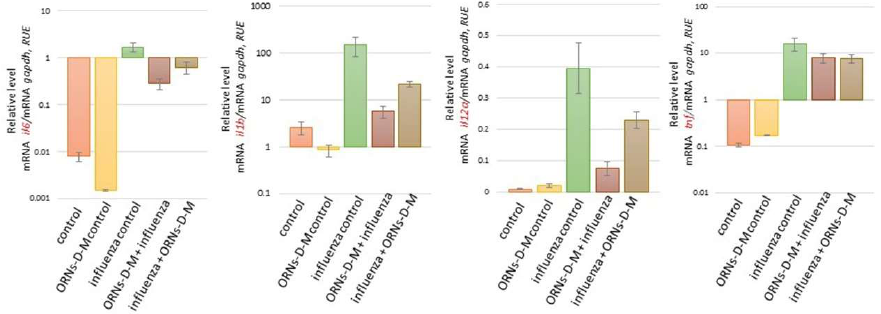
Figure 4. Impair the pro-inflammatory cytokines il6 , il1b , il12a , and tnf overexpression induced by an influenza virus A/Fort Monmouth/1/1947-mouse adapted (H1N1) owing to the ORNs- D -М in vivo. Before and after infection with the influenza virus FM147 (4.0 lg LD 50 ), the BALB/c mice were treated with ORNs- D -М. Total RNAs from the mice lungs were isolated and RT-qPCR was performed. Samples were normalized to gapdh as a control. RUE: relative units of expression. ORNs- D -М control—ORNs- D -М injection into healthy mice, influenza control—infection of mice with influenza virus, ORNs- D -M + influenza—ORNs- D -M injection 24 h before infection with the influenza virus and prevention with ORNs- D -M, and influenza + ORNs- D -M—ORNs- D -M injection 24 h after infection with influenza virus and treatment with ORNs- D -M. Data are shown as the mean ± SD for three independent